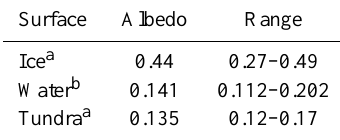
Table B1. Albedo values and parameter range. Surface